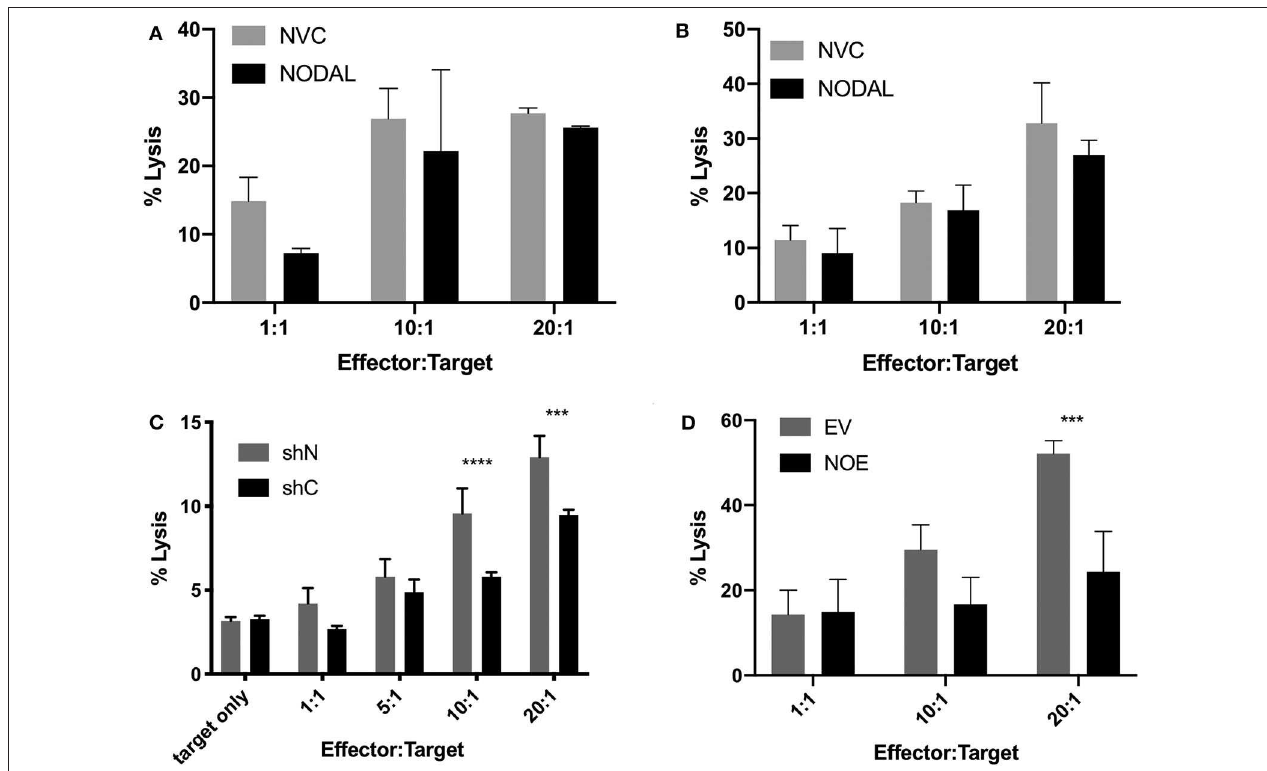
FIGURE 4 | NODAL expression inversely correlates with susceptibility of breast cancer cells to γδ T cell cytotoxicity. (A) , NODAL stimulation during a 4-h Calcein AM-release cytotoxicity assay does not impact γδ T cell cytotoxicity against MCF-7 cells. NVC, NODAL vehicle control; n = 3 independent experiments. (B) , Long term NODAL stimulation has no impact on γδ T cell cytotoxicity against MCF-7 cells. γδ T cells were stimulated one time with NODAL vehicle control (NVC) or 100ng/ml recombinant human NODAL, then 9 days later were co-incubated for 4h with Calcein-AM labeled MCF-7 target cells at the indicated Effector:Target (E:T) ratio. (C) , Representative example in which day 21 γδ T cells and shC or shN MDA-MB-231 target lines were co-incubated for 4h at the indicated E:T, and acquired via flow cytometry. *** P = 0.0002, **** P < 0.0001; n = 6 independent experiments. (D) , Overexpressing NODAL in T47D cells (NOE) confers significantly greater resistance to γδ T cell cytotoxicity as shown in a Calcein AM-release cytotoxicity assay; EV = empty vector control; A, B, D, Calcein AM assays; *** P = 0.0007; representative of n = 4 independent experiments. (A–D) Error bars are SD (3 technical replicates). P -values were calculated with 2 way ANOVA followed by Bonferroni multiple comparisons